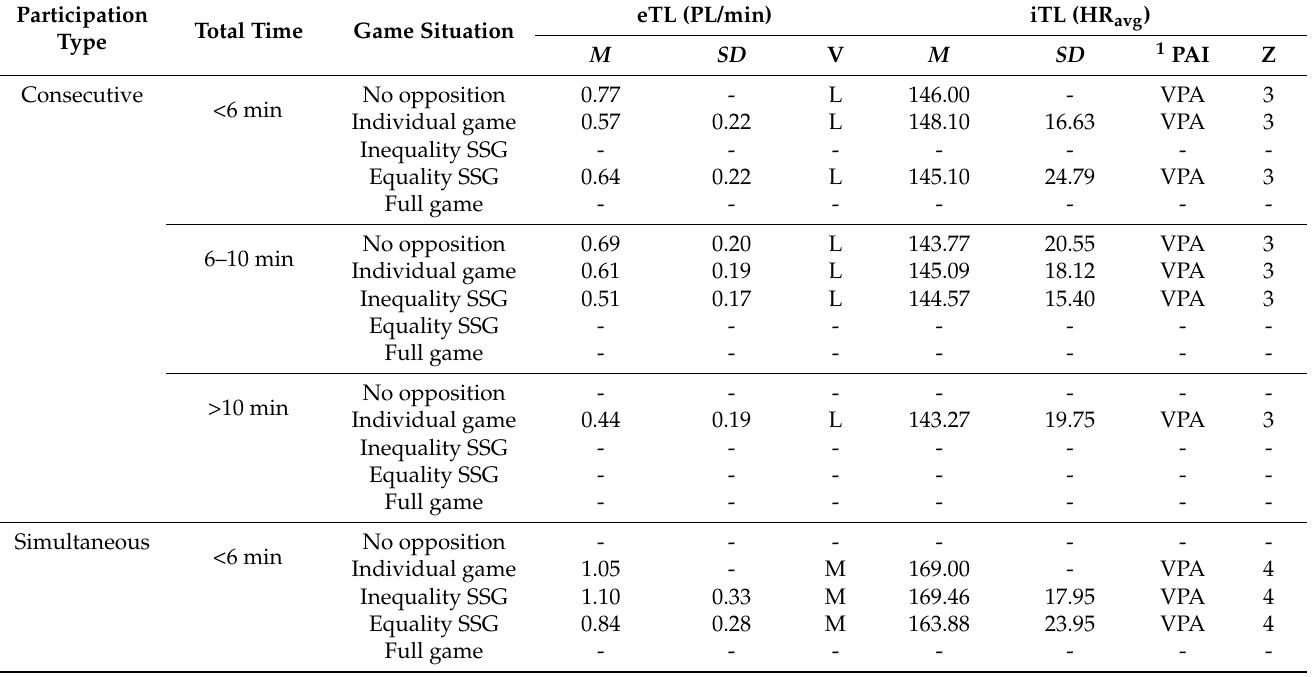
Table 5. Reference values according to the interaction of the independent variables.